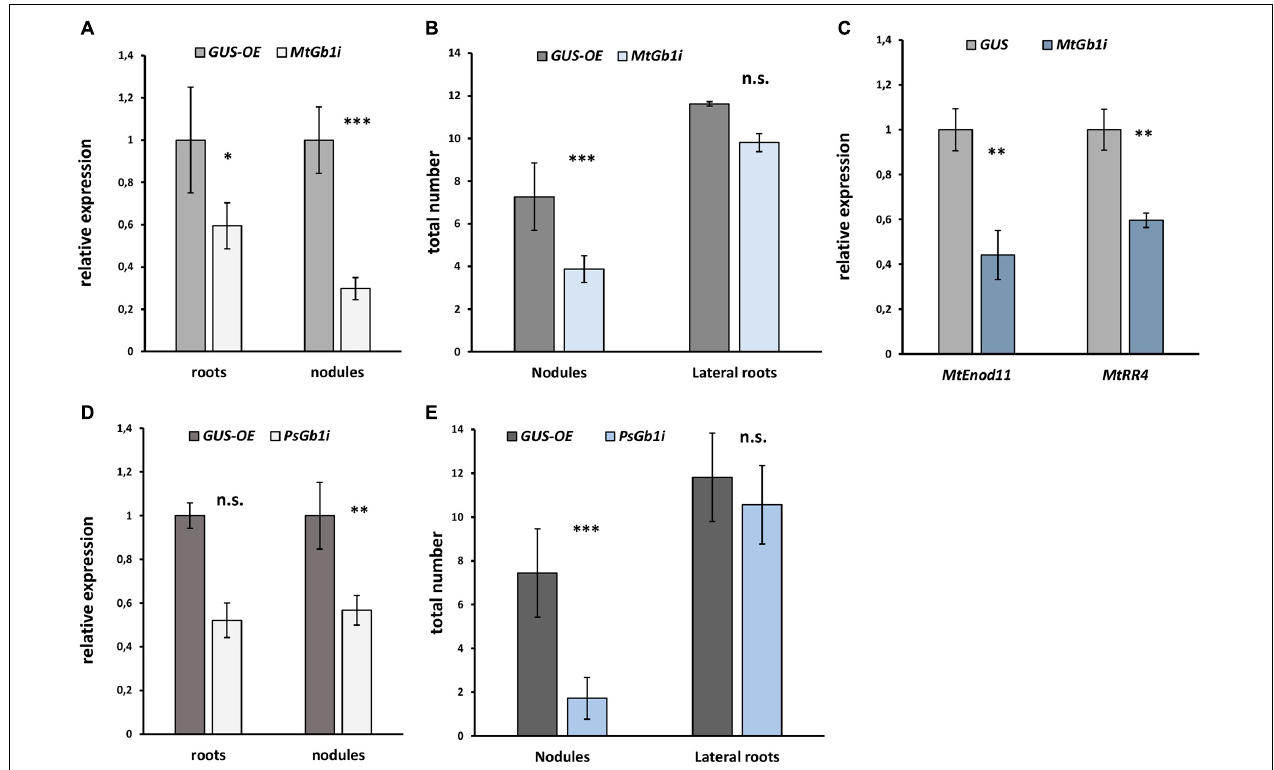
FIGURE 2 | The effect of Gbeta1 gene suppression on root development and nodulation in M. truncatula A17 (A,B) and P. sativum cv. Finale (D,E) plants. Composite plants with the Gbeta1 gene suppression in transgenic roots ( Gbeta -RNAi) were compared with control plants with β -glucuronidase gene overexpression ( GUS -OE). Analysis was performed two weeks after inoculation (2 wai) ( M. truncatula ) and 3 weeks after inoculation (3 wai) ( P. sativum ). Approximately 50% suppression of the Gbeta1 gene in the transgenic roots and nodules of both legumes was revealed (A,D) . The number of nodules in transgenic fluorescent roots of Gbeta -RNAi plants was significantly reduced (B,E) , whereas the total number of transgenic fluorescent lateral roots did not change in both cases. Expression of early symbiotic markers, the MtEnod11 and MtRR4, in the transgenic hairy roots of MtGbeta1 -RNAi plants (C) . Two biological replicates were analyzed for M. truncatula and P. sativum , each contained 15 – 20 plants per variant. In case of M. truncatula totally 47 and 26 transgenic fluorescent roots of MtGbeta -RNAi and GUS -OE plants, correspondently, were included in the analysis, while 29 and 16 transgenic fluorescent roots of PsGbeta -RNAi and GUS -OE plants were used in P. sativum . The number of nodules were scored only in transgenic fluorescent roots. Values are means ± SEM. ∗ , Significant difference at P ≤ 0.05; ∗∗ , Significant difference at P ≤ 0.01; ∗∗∗ , Significant difference at P ≤ 0.01; ns, non-significant